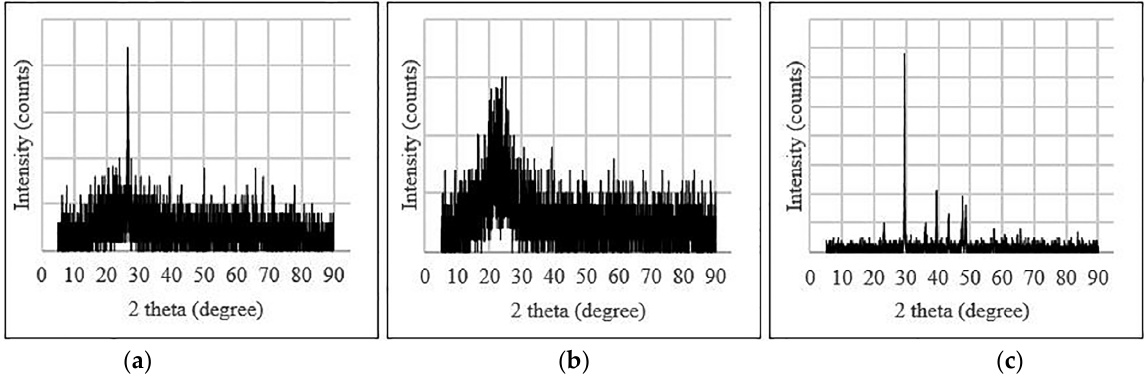
Figure 11. The XRD pattern for ( a ) fly ash ( b ) nano SiO 2 , and ( c ) nano-CaCO 3 (reproduced Copyright 2022, with permission from Wiley [20]).